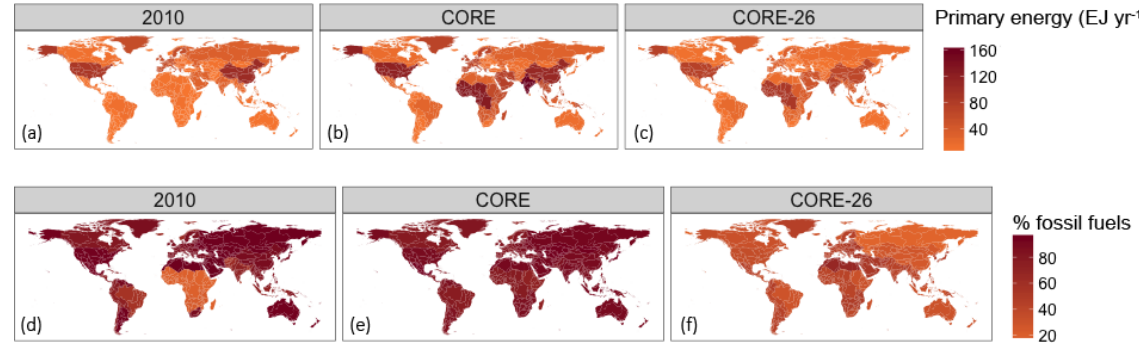
Figure 6. Regional primary energy consumption (a–c) and percentage (%) of primary energy from fossil fuels (d–f) in 2010 (a, d) and 2100 in the CORE (b, e) and CORE-26 (c, f) scenarios. Primary energy is reported using a direct equivalent; that is, 1EJ of nuclear or renewable electricity is reported as 1EJ of primary energy